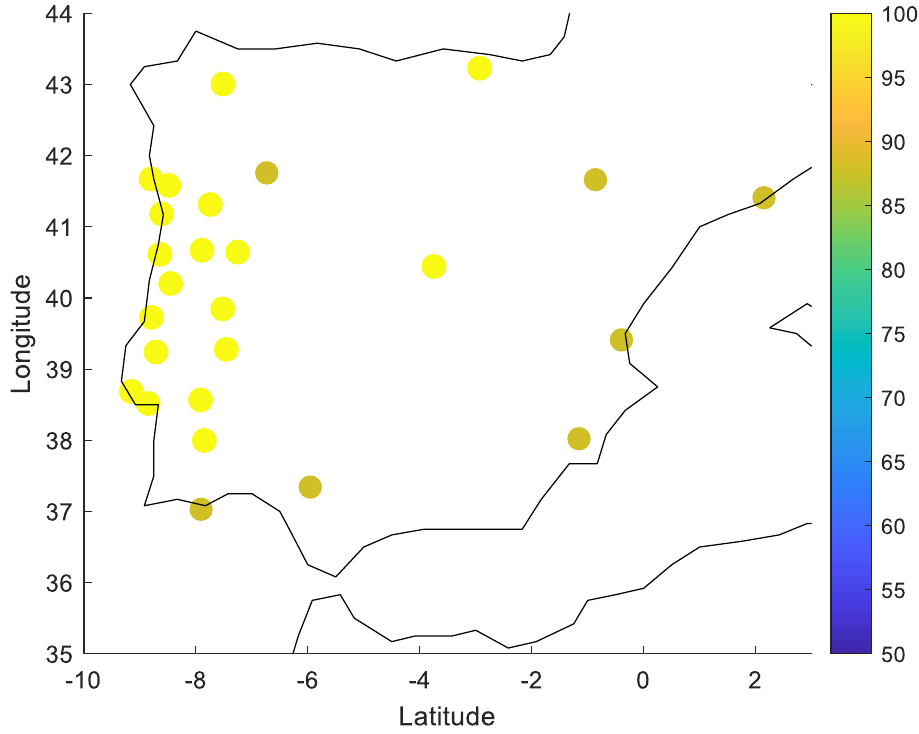
Figure 7. Average percentage of time for the November–June period that wind shear 0–6 km di ff erences, future minus historic, are positive.